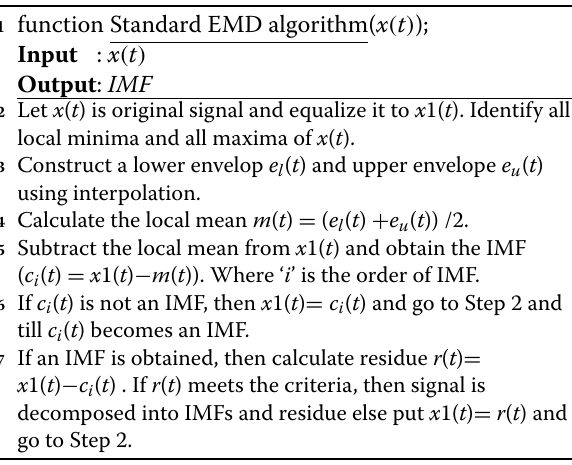
Algorithm 1: Standard EMD